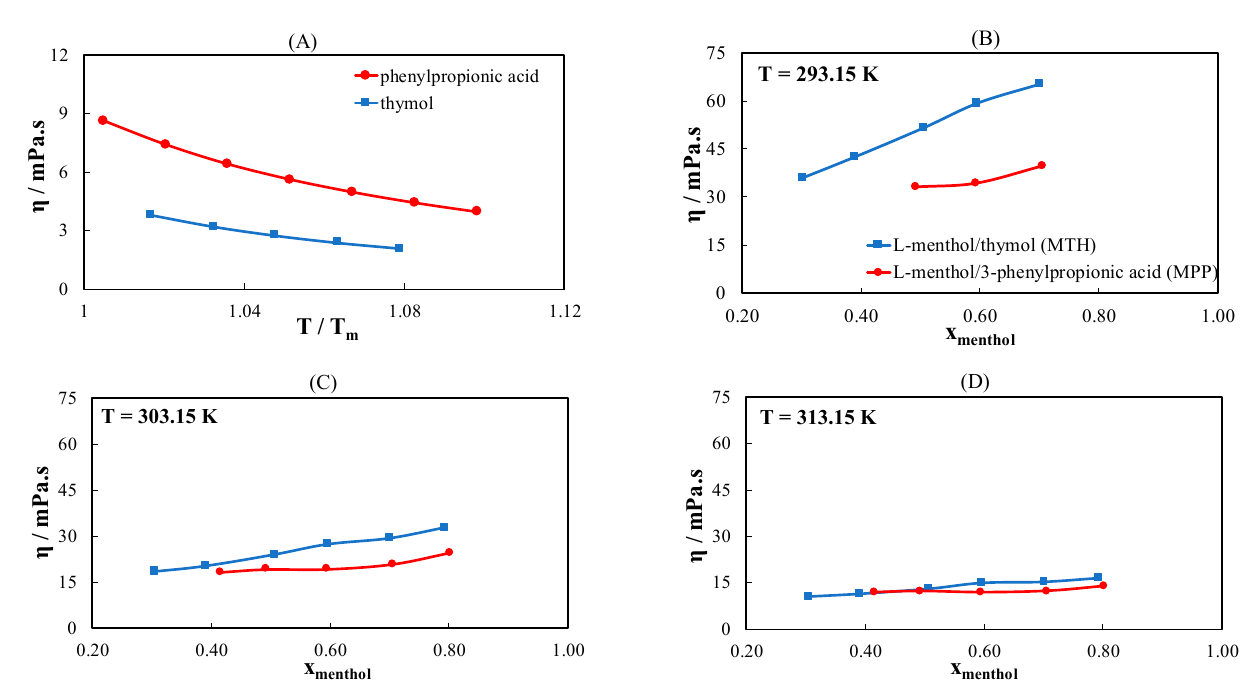
Figure 7. ( A ) Viscosity of thymol and 3-phenylpropionic acid as a function of the scaled temperature. ( B ) Viscosity of the eutectic systems containing L -menthol with thymol or 3-phenylpropionic acid as a function of the L -menthol composition at ( B ) T = 293.15 K, ( C ) T = 303.15 K, and ( D ) T = 313.15 K.